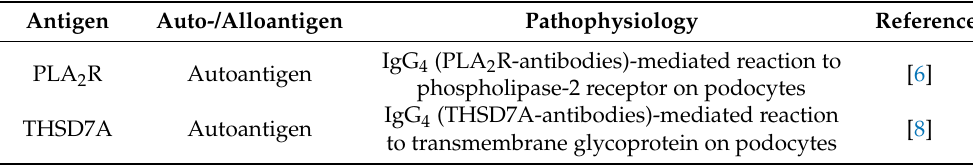
Table 2. Auto- and alloantigens in MN.